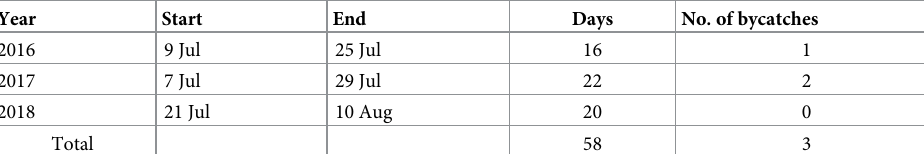
Table 1. Periods of the A-tag acoustic observations and the bycaught harbour